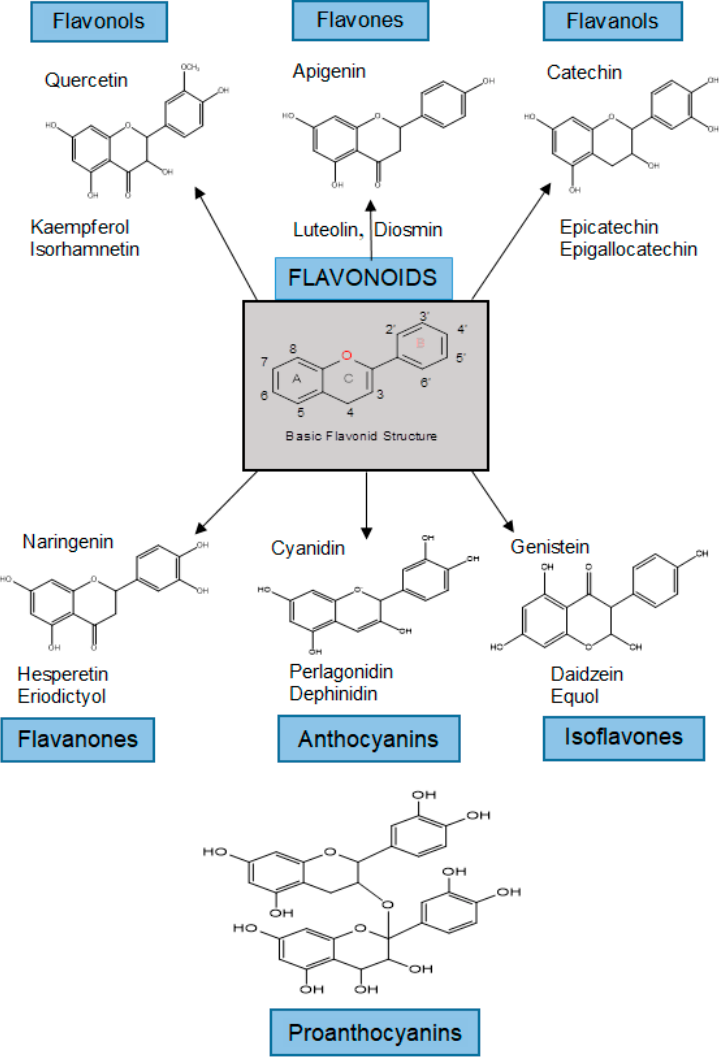
Figure 1. Classification and examples of structures of